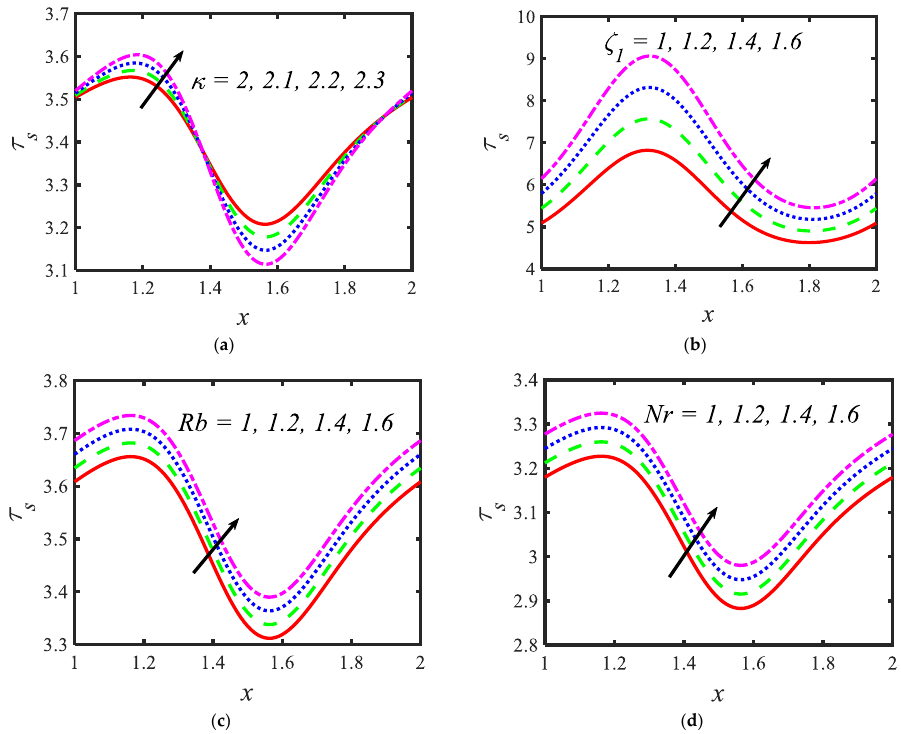
Figure 7. Variations in the shear stress profiles for ( a ) the electroosmosis parameter, ( b ) zeta potential, ( c ) bioconvection Rayleigh constant and ( d ) buoyancy ratio constant.